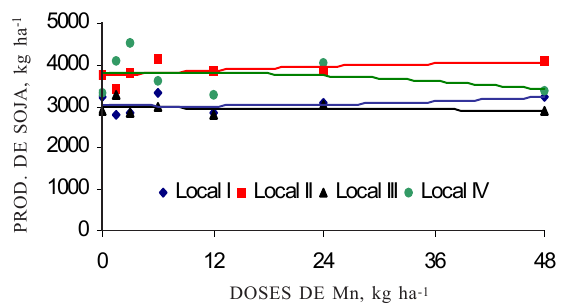
Figura 10. Produtividade de soja em quatro locais, considerando as doses de manganês. Local I: